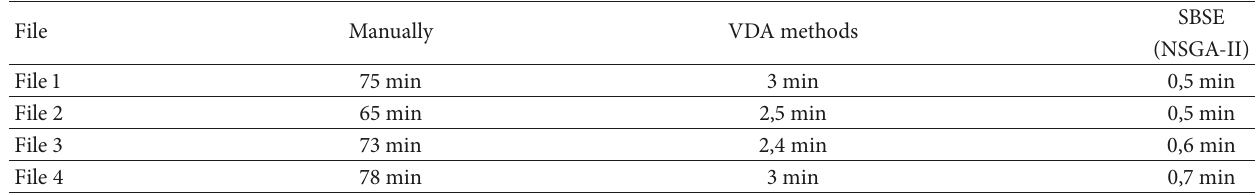
Table 8: Comparison of time spent between three methods of